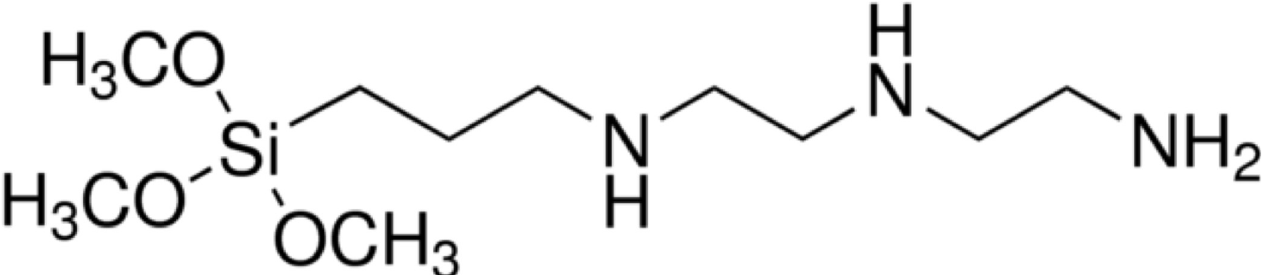
Fig 1. Molecular structure of N1-(3-trimethoxysilylpropyl)diethylenetriamine (SiDETA).